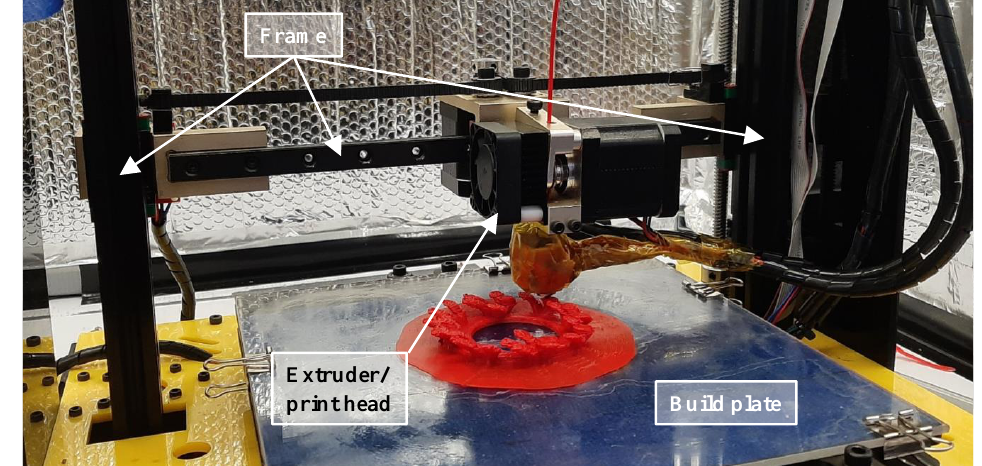
Figure 1. Typical hardware for the FDM process.